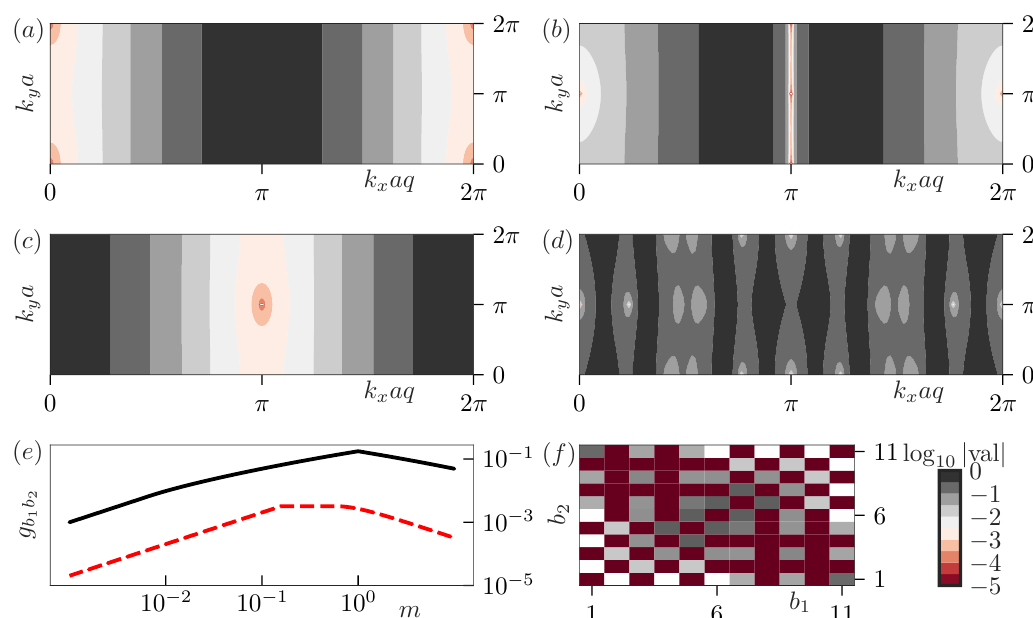
| Ω ( k ) | , the 10 | Ω ( k ) | = 1 sets the normal- k | Ω ( k ) | ( g ) as a function of m = max k ∈ BZ 1,11 1,2 1 g for m maximizing b 1 b 2 10 ) . Red squares correspond to ( b ) where g = , b , b b 1 b 2 1 2 1 2